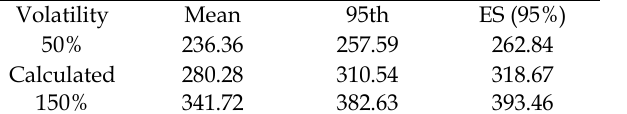
Annual 2019 cost sensitivity to Tobit volatility (millions